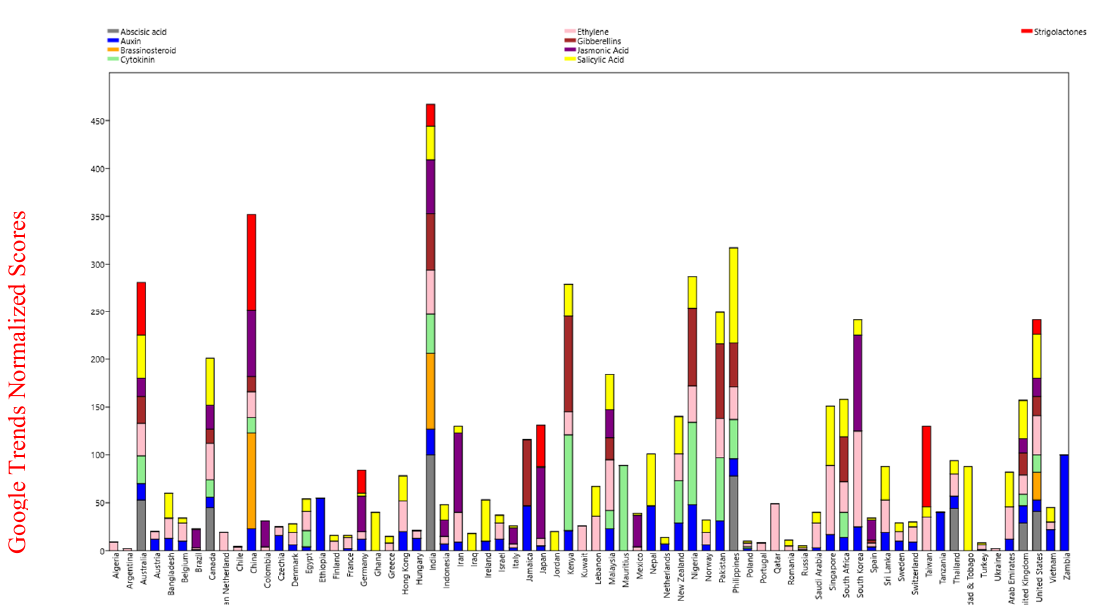
Figure 4. Stacking and area chart of phytohormone search of few countries. The data that resulted from the Google trend search was considered to draw the graph. From the figure, it can be observed that only India and the United States of America show nine stacks describing the search query for all the nine phytohormones. Australia has eight, China and the United Kingdom have seven, and the Philippines has six stacks, showing the respective phytohormone searches in these countries.